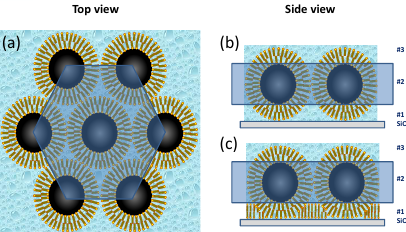
Figure 6. ( a ) Top view of the close-packed arrangement of NPs in a wetting layer with six-fold symmetry, and side views of models for ( b ) close-packed NPs that are intact and ( c ) that have an